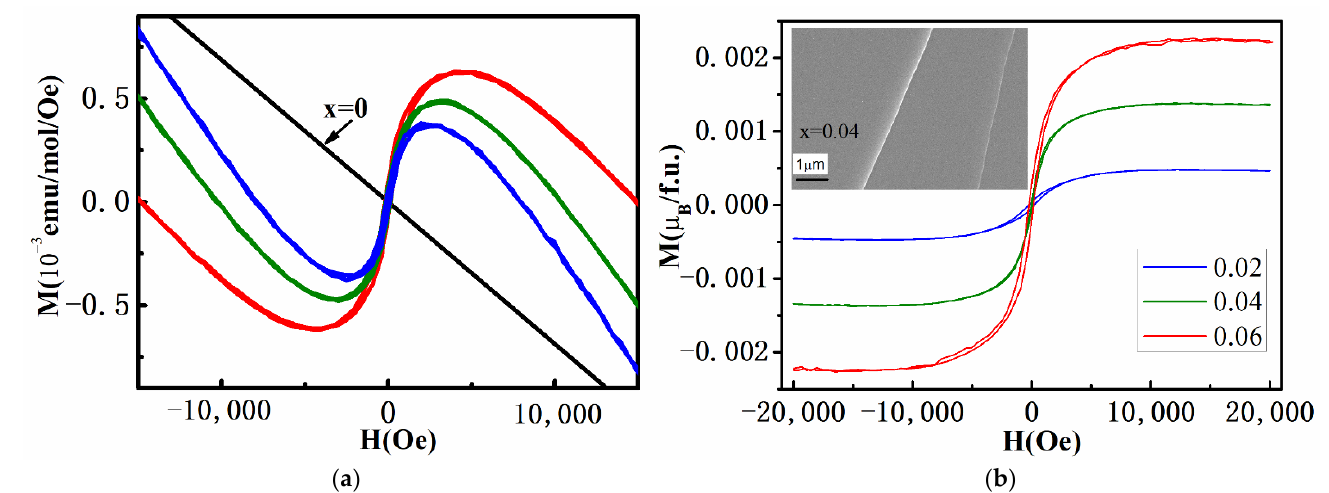
Figure 5. ( a ) Magnetization versus applied magnetic field for C x Bi 2 Se 3 measured at 15 K. ( b ) The magnetic hysteresis loops after subtracting the diamagnetic signals. There is obvious magnetic hysteresis in all doped samples. Inset: FESEM images of C 0.06 Bi 2 Se 3 crystal. Table 2. Lists of remnant magnetization, saturation magnetization and coercivity for C x Bi 2 Se 3 . Saturation Magnetization Remanent Magnetization Coercivity M Smol x M r [ μB /f.u.] H c (Oe)